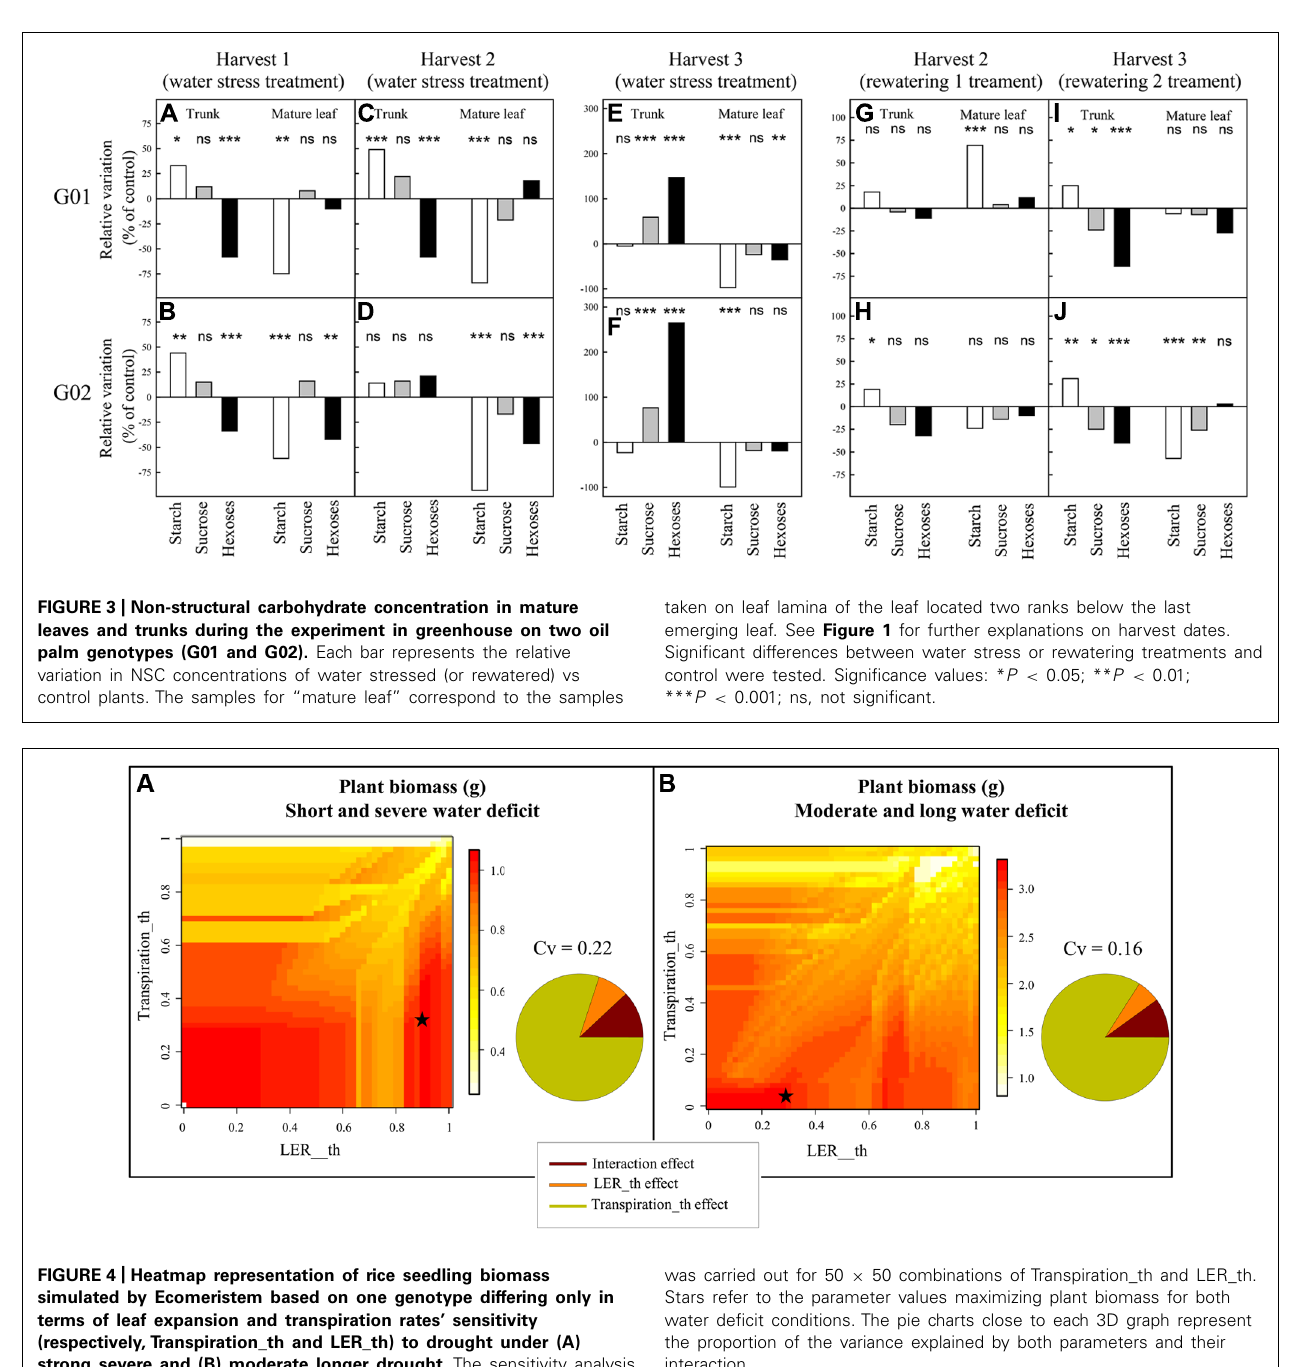
FIGURE 4 | Heatmap representation of rice seedling biomass simulated by Ecomeristem based on one genotype differing only in terms of leaf expansion and transpiration rates’ sensitivity (respectively, Transpiration_th and LER_th) to drought under (A) strong severe and (B) moderate longer drought. The sensitivity analysis